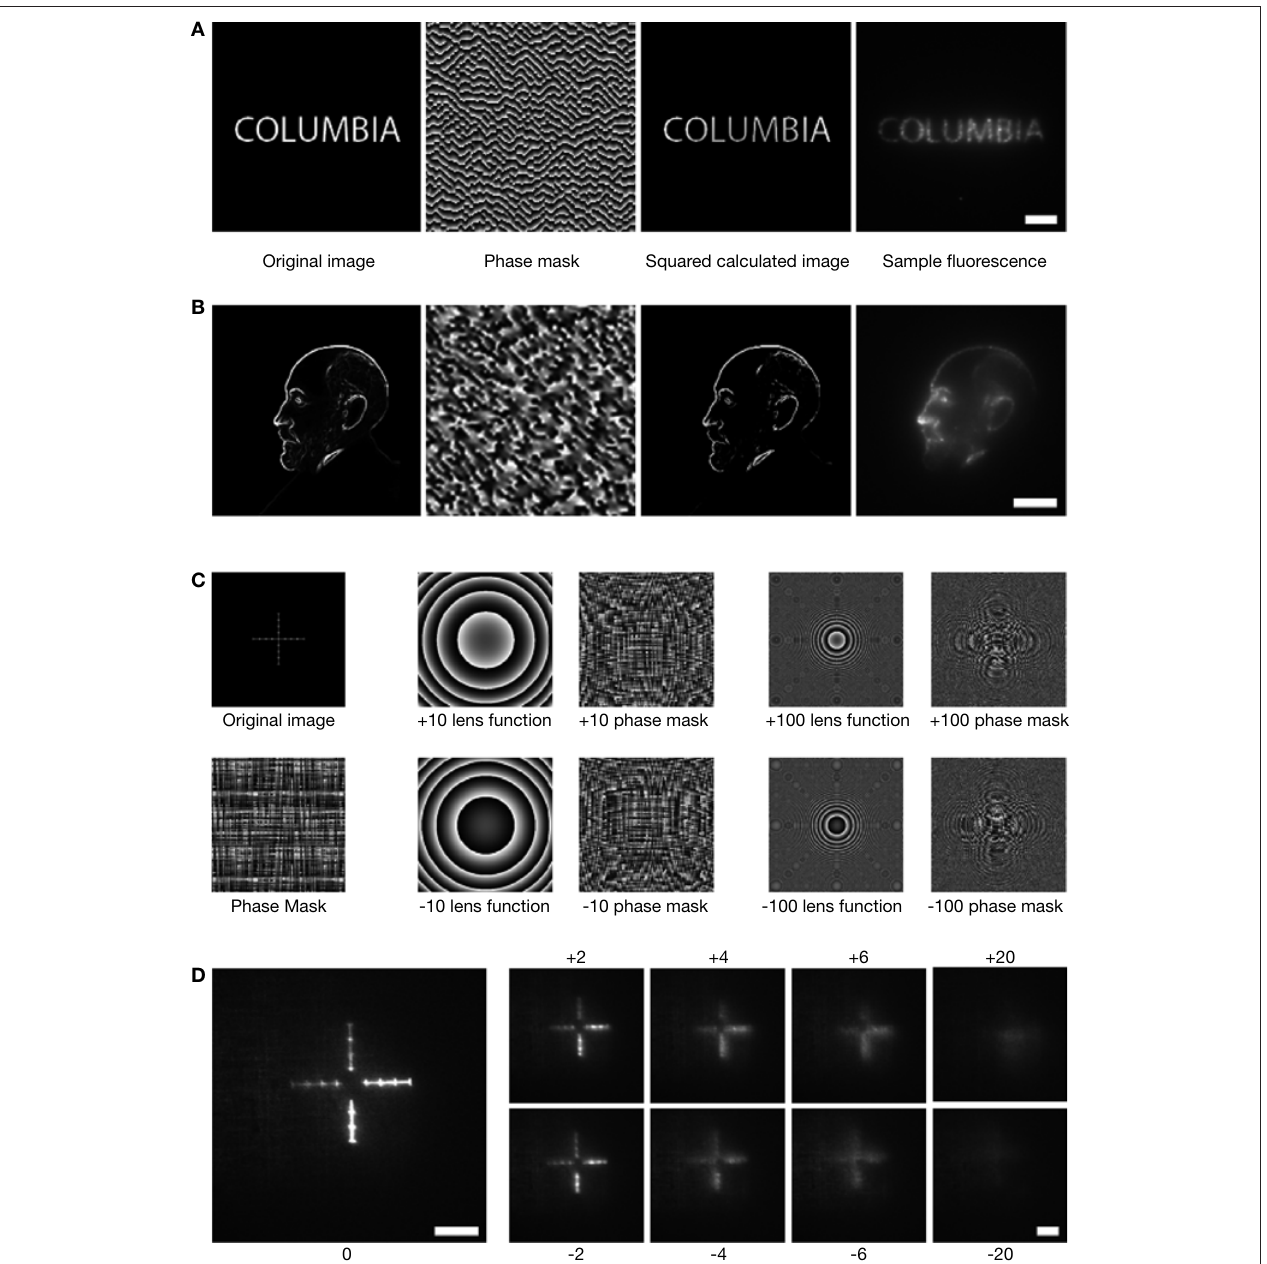
non-linear illumination. (B) Complex grayscale patterns can be used to program SLM. We used a stylized picture of Santiago Ramón y Cajal, based on a historical photograph. Panels are similar to panel (A) . (C) Focusing with an SLM. Our SLM software allows applying additional optical functions on top of the phase mask. In this example we used a lens function to shift the focus of excitation in axial dimension. The panel shows the original image and corresponding phase mask, as well as lens phase function alone and added to original phase mask. − 10, − 100, + 10 and + 100 are arbitrary units used by software to indicate correspondingly negative/positive lens and relative optical strength. (D) Two-photon fl uorescence image of the test pattern acquired with the CCD camera. The virtual focus plane is moved away in both directions from the original plane using a lens function of corresponding strength. A 40 × 0.8 NA objective was used. Scale 50 μ m. These data illustrate that SLMs can be used as a “universal scanners” that do not require physically moving